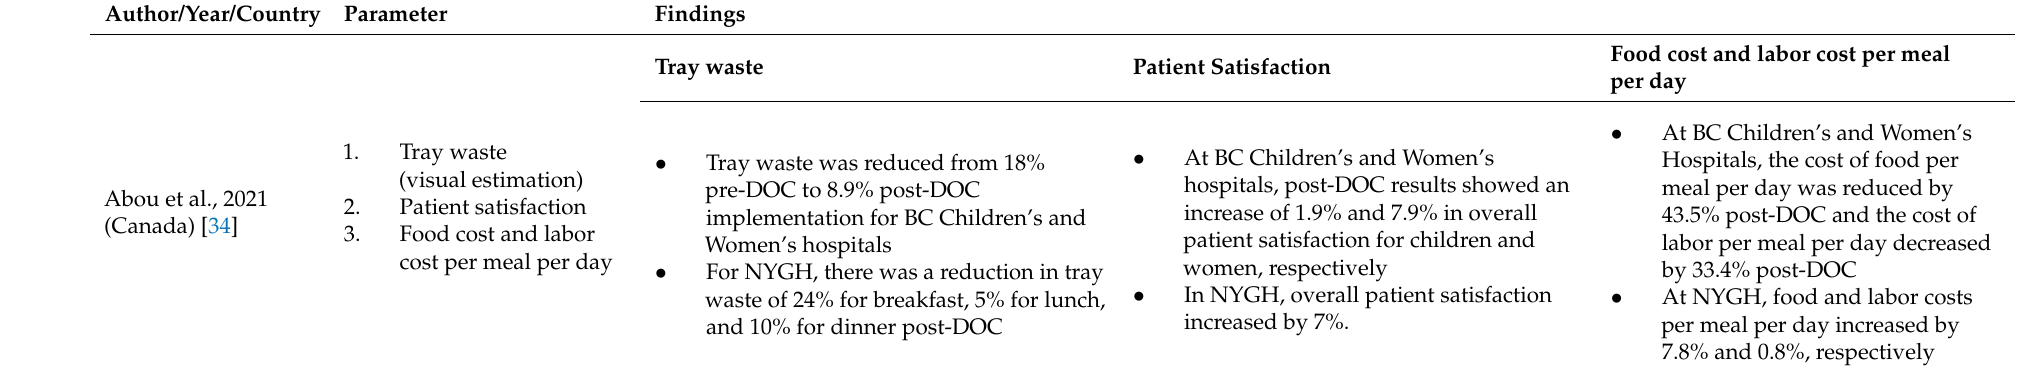
Table 3. The impact of the strategies on other parameters and plate